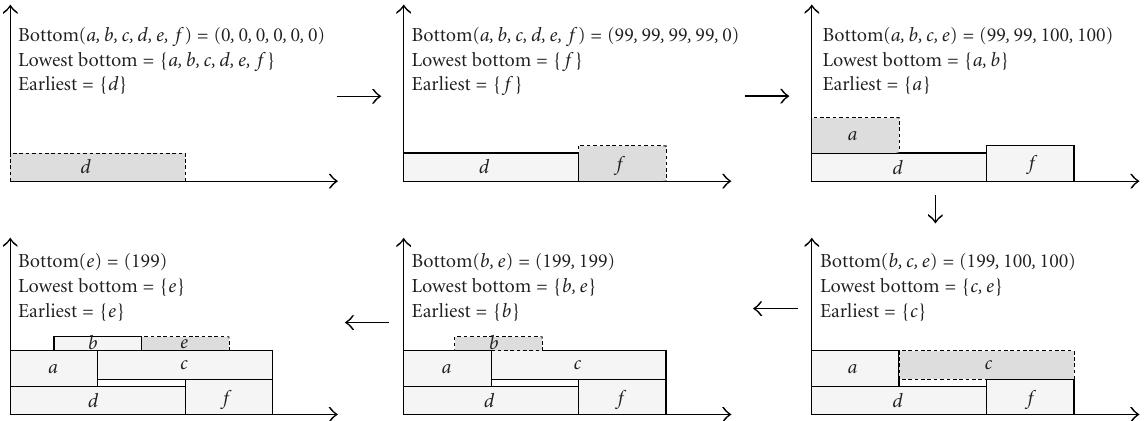
Figure 15: The proposed placement algorithm at work.